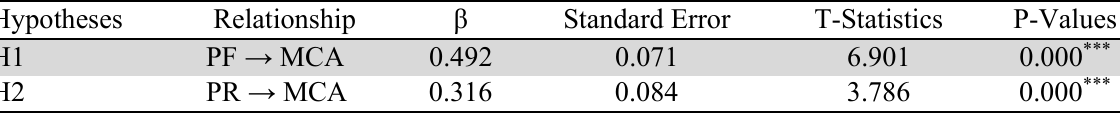
Result of Hypothesis testing Hypotheses Relationship β Standard